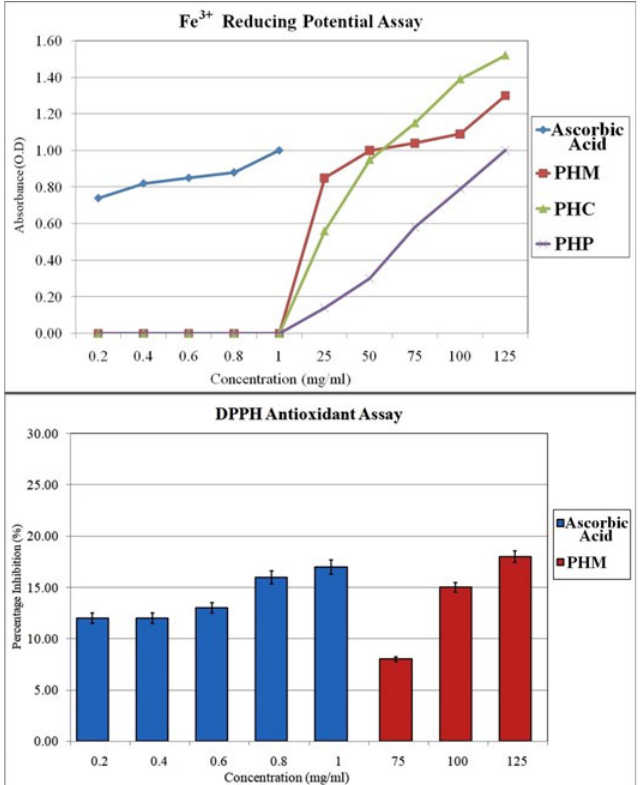
Fig 2. Antioxidant potential of Parthenium hysterophorus via Fe 3+ reducing potential assay and DPPH